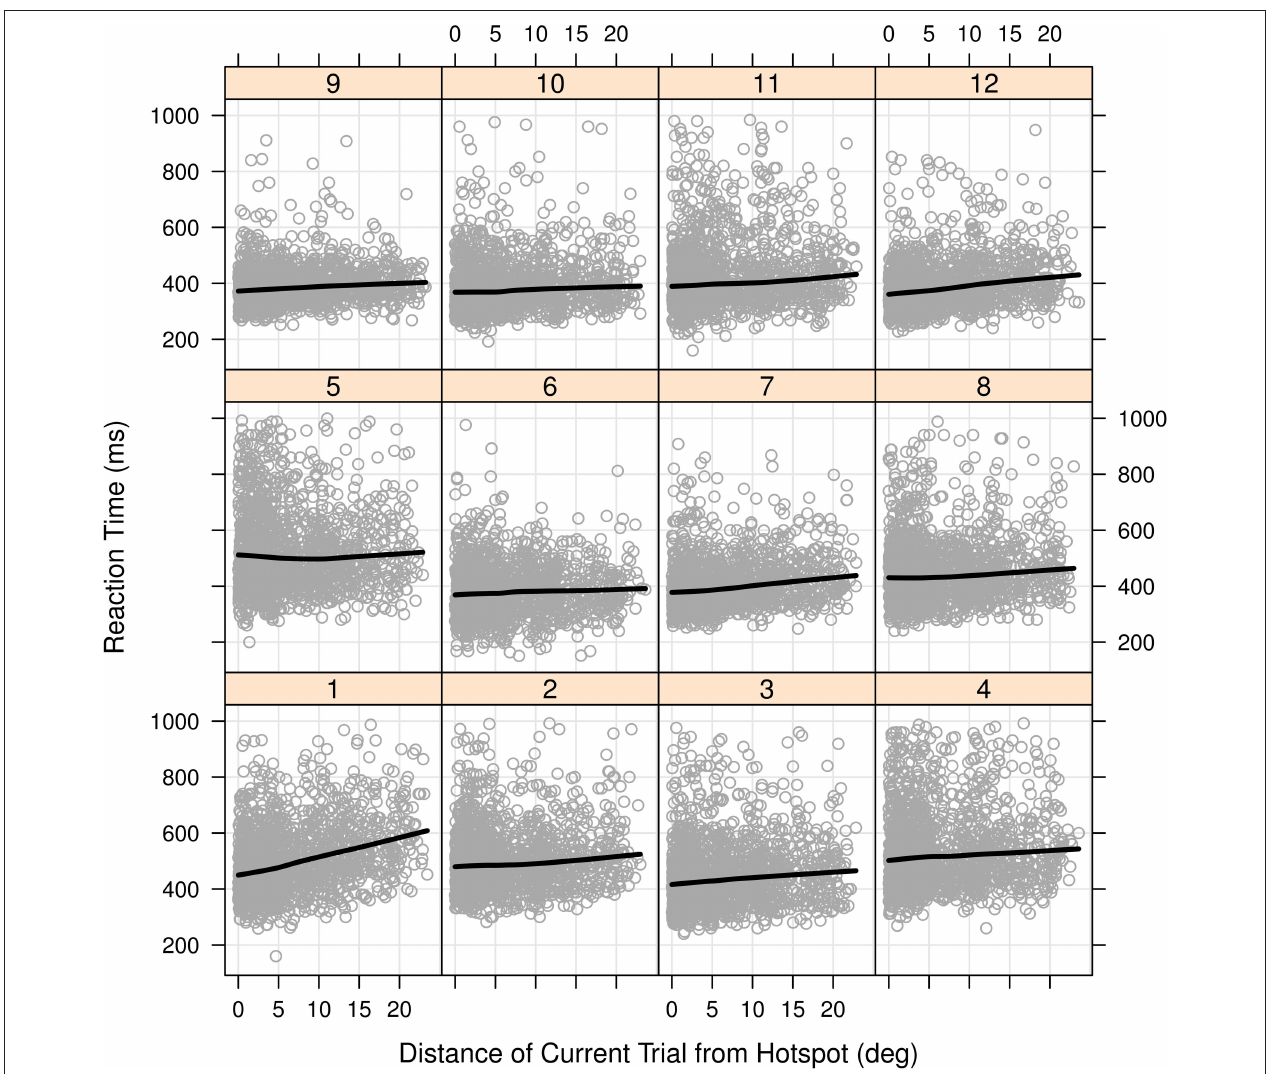
weighted scatterplot smoothing using the xylowess function in the R Statistical Language. Linear regression on the individual plots showed ten out of the 12 regression slopes were significantly positive, at p <